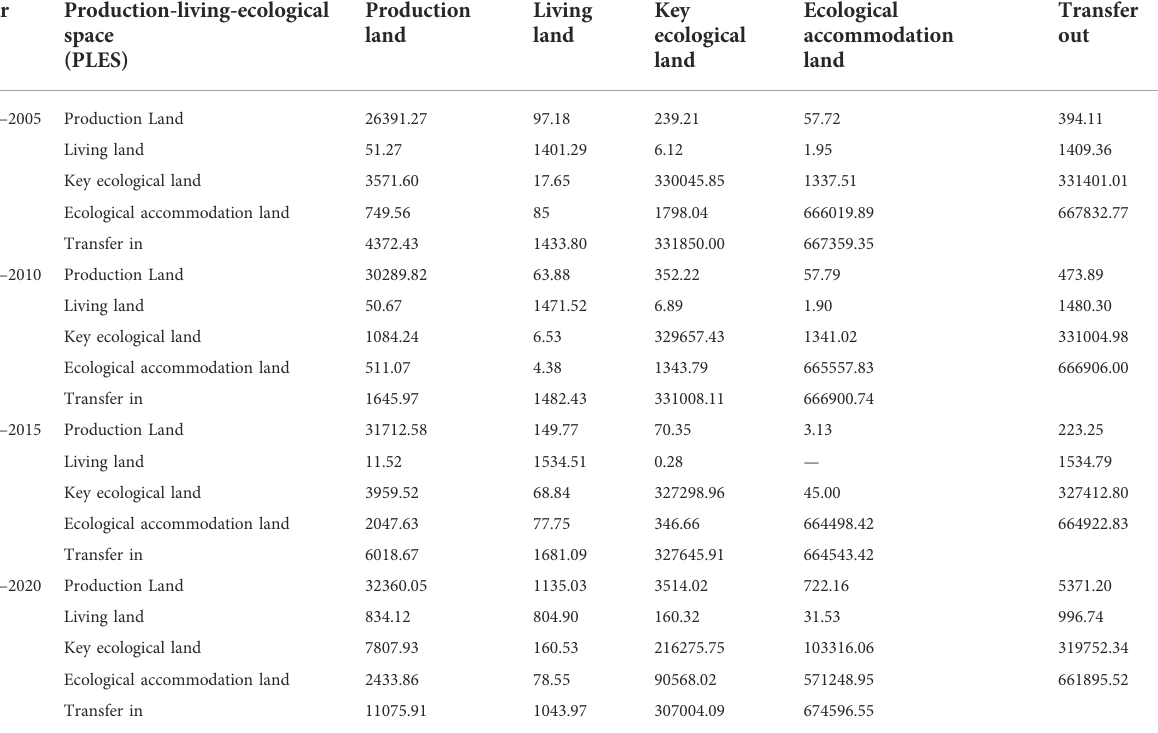
TABLE 2 Transition matrix of production-living-ecological space (PLES) for different periods in the Tarim River Basin during 2000 –